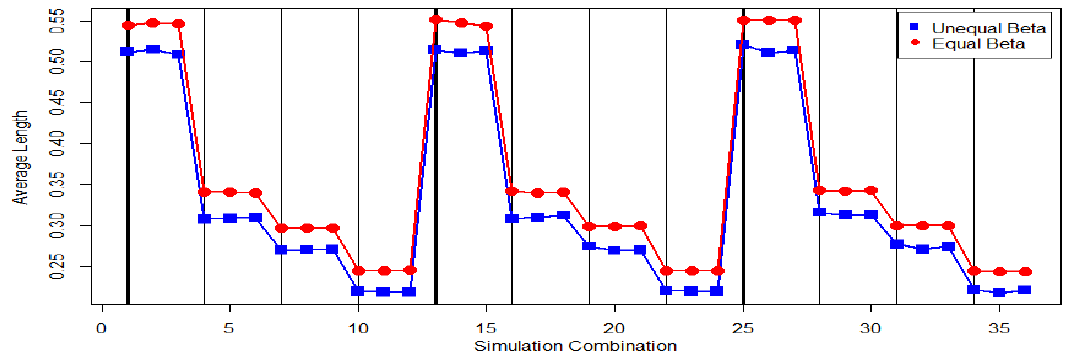
Figure 14. Average length of covering confidence intervals